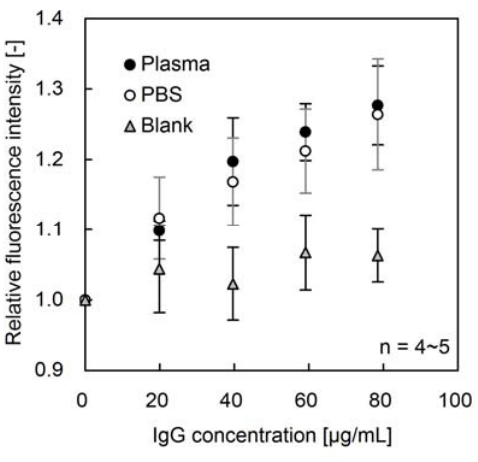
Figure 3. Dependency of relative fluorescence intensity on IgG concentration. Black circles denote FITC-protein A immobilized glass in bovine plasma, White circles denote FITC-protein A immobilized glass in PBS, Gray triangles denote plasma solution without glass for blank